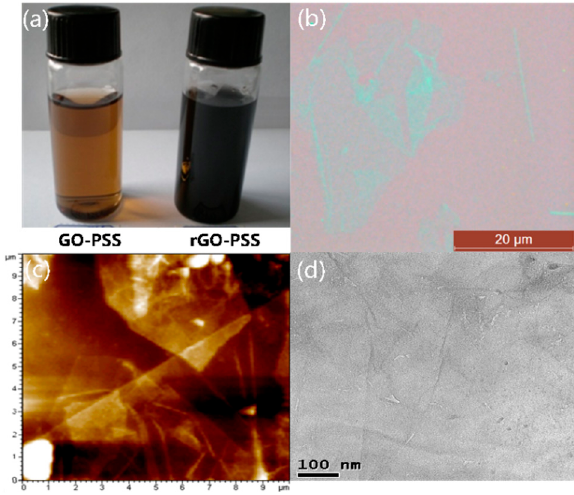
Figure 2. Characterizations: ( a ) GO-PSS solutions before and after reduction; ( b ) optical micrograph of GO-PSS sheets; ( c , d ) AFM and TEM images of rGO-PSS sheets, respectively.